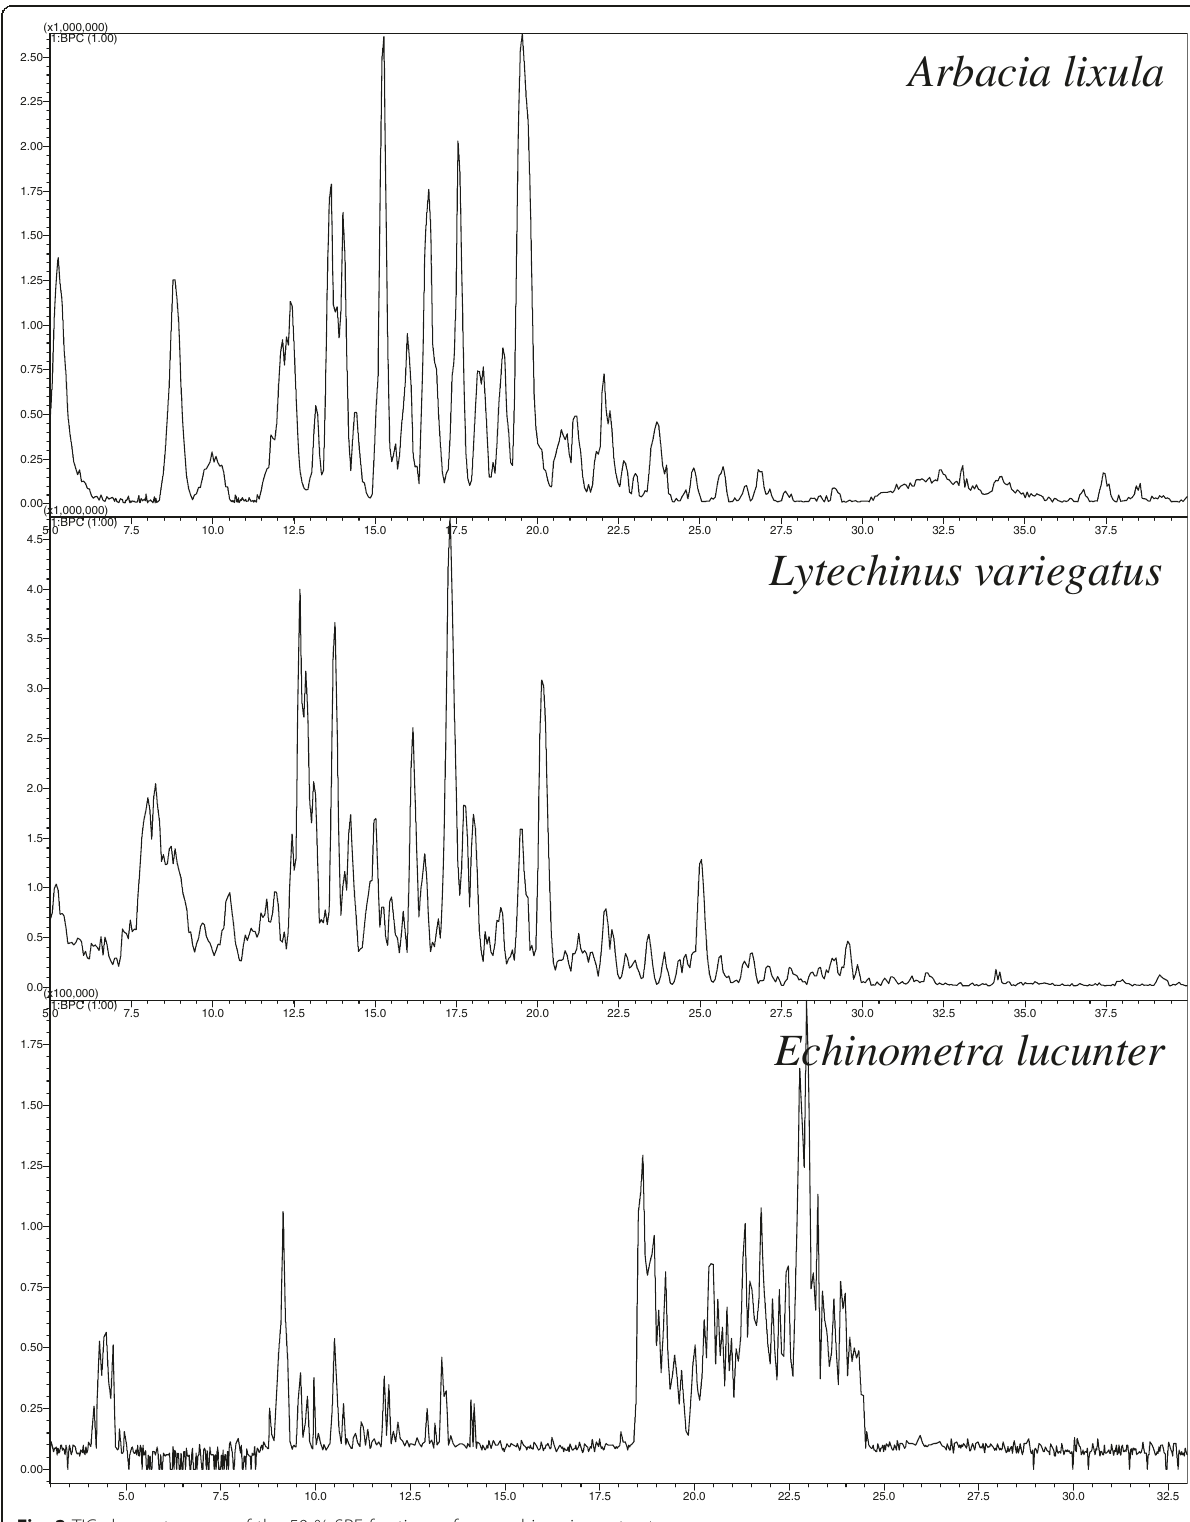
Fig. 2 TIC chromatograms of the 50 % SPE fractions of sea urchin spine